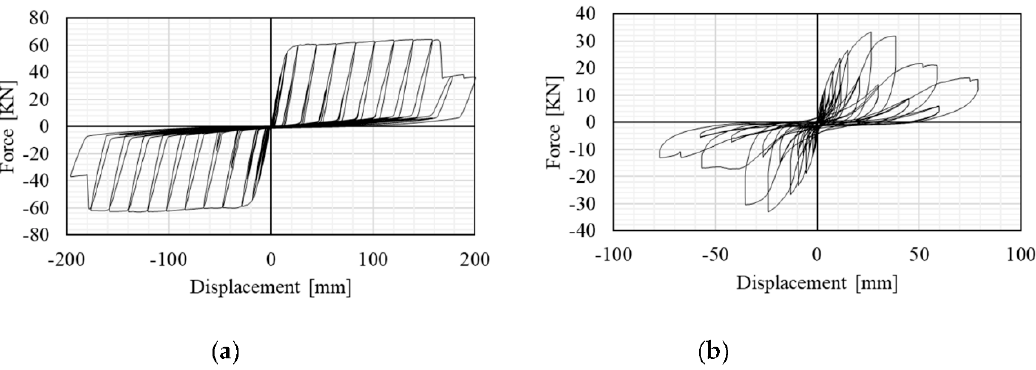
Figure 6. Hysteretic response of typical CFS lateral force resisting systems. ( a ) CFS strap-braced walls [5]; ( b ) CFS gypsum sheathed shear walls